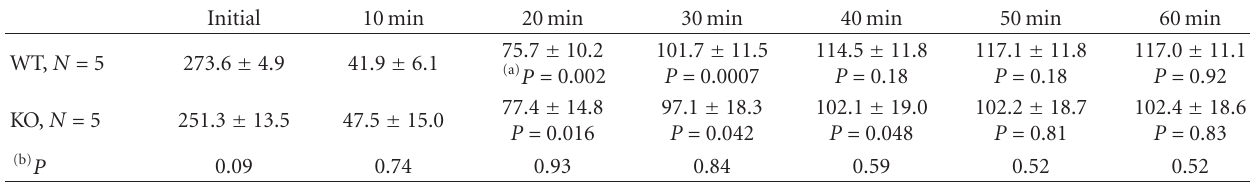
Table 1: Tetanic forces (kN/m 2 ) of WT and dysferlin-null EDL muscles at room temperature before and after saponin exposure. Initial